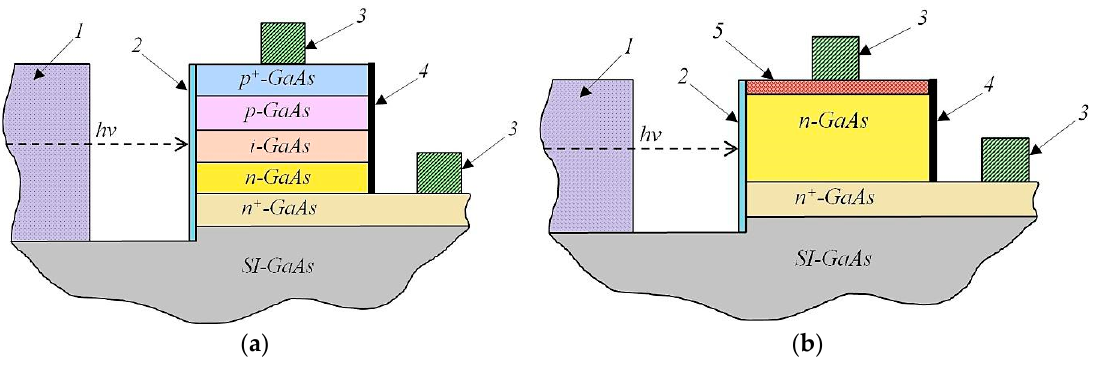
Figure 3. Structures of the researched photodetectors for on-chip optical interconnections: GaAs p-i-n ( а ) and Schottky-barrier ( b ) photodiodes: 1, integrated optical waveguide; 2, half reflecting mirror; 3, ohmic contacts; 4, totally reflecting mirror; 5, metal layer of Schottky contact. Table 1. Impurity concentrations in the regions of photodetectors.